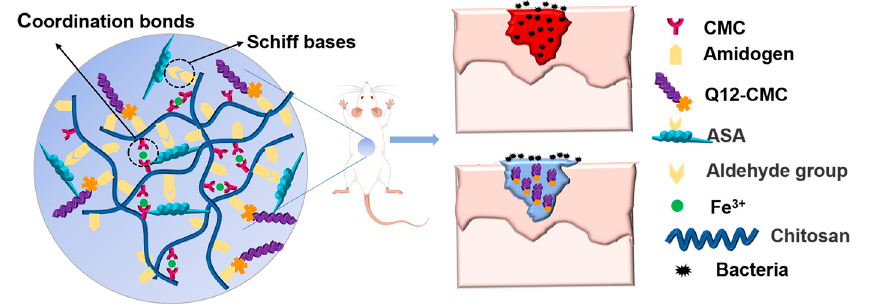
Figure 1. Schematic illustration of the preparation and application of QAF hydrogels.